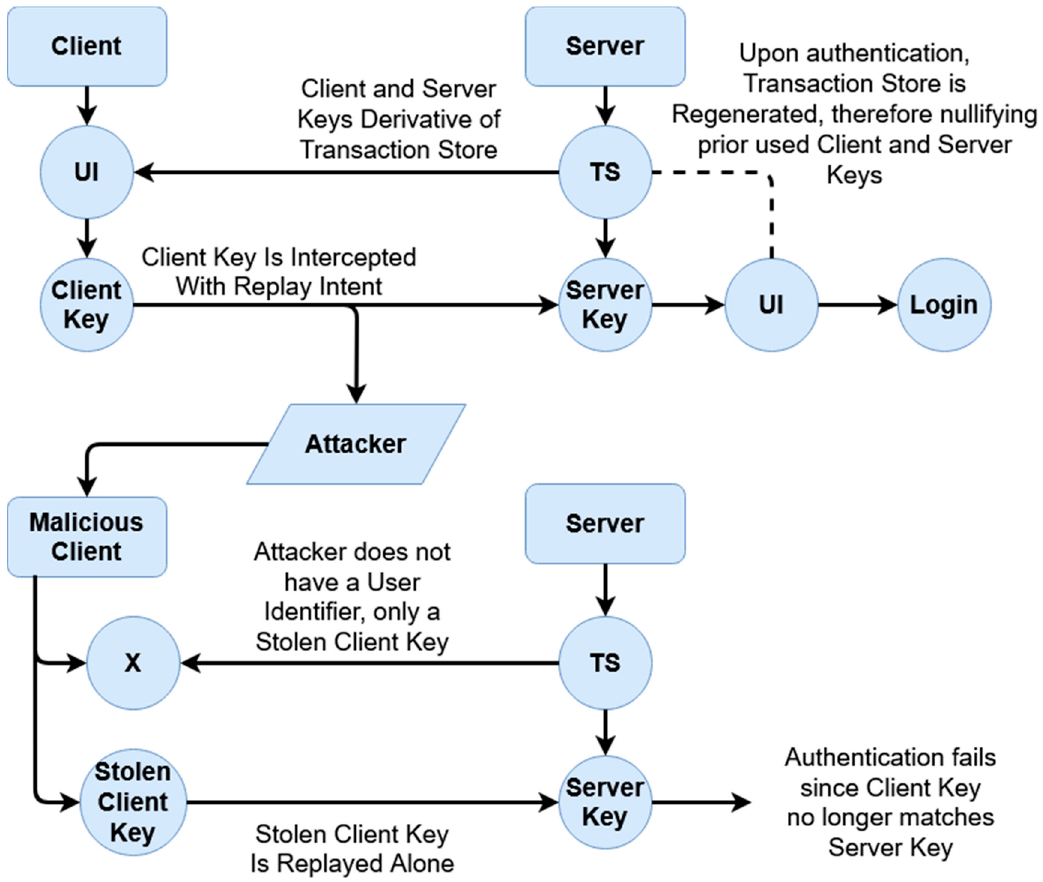
Figure 13. A replay attack under TFHVA scheme.